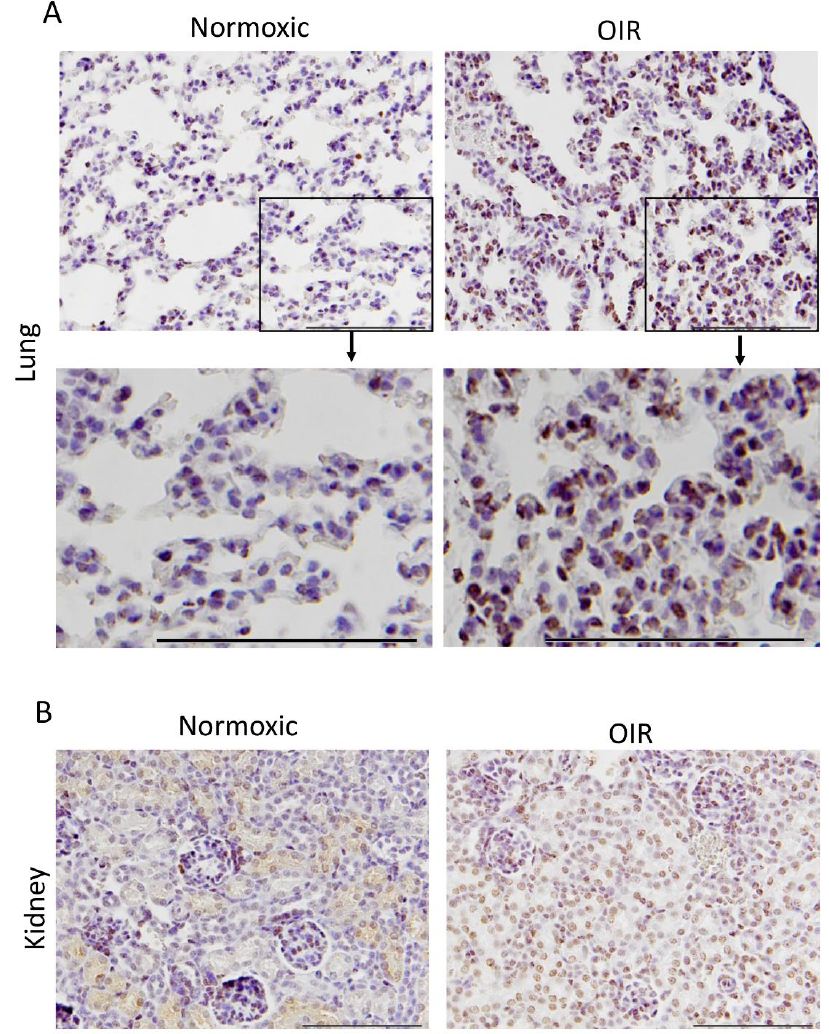
Figure 3 . CAR-peptide homes to the lungs of OIR mice . Lung ( A ) and kidney ( B ) cross sections from